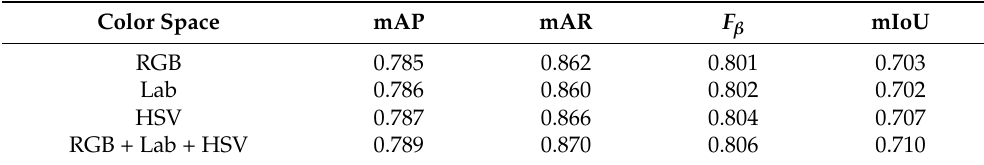
Figure 7. Influence of parameters k 0 and λ c on our approach. Table 5. Performance of our CCNN-based approach on VOS when using different color spaces in constructing neighborhood reversible flow.